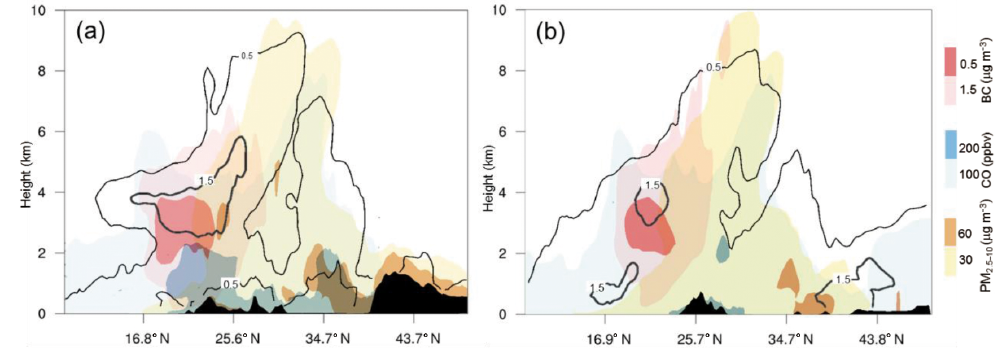
Figure 13. Cross section of averaged pollutants from FF (CO), BB (BC), and dust (PM 2 . 5–10 ) and air temperature change diagnosed by EXP_WF and EXP_WoF ( ◦ C) at (a) 115 ◦ E and (b) 120 ◦ E during 22–24 March